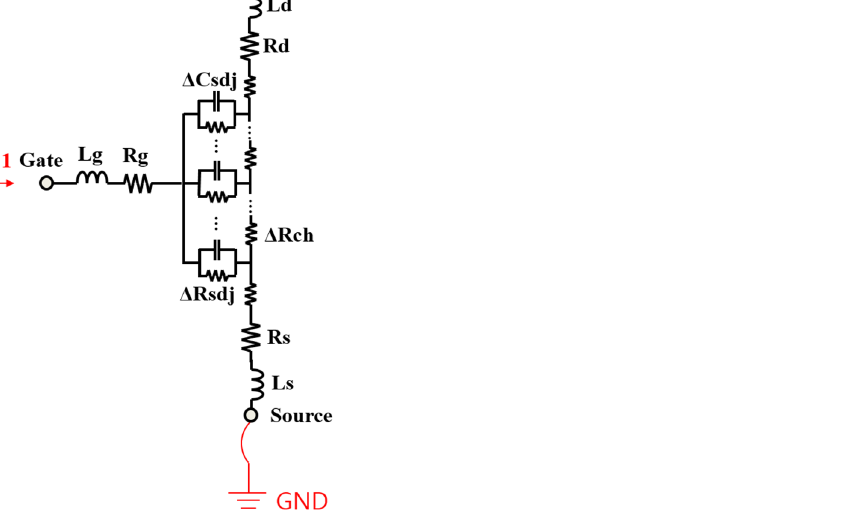
Figure 6. Schematic of GaN HEMT small-signal equivalent circuit in the cold bias region.